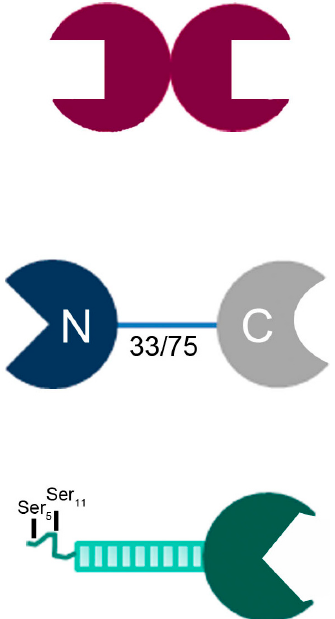
Figure 1. Illustration of the structural design of the three classes of vertebrate galectins, i.e., non-covalently associated homodimer (proto-type), covalently linked heterodimer (with natural variability of linker length by alternative splicing, here given in number of amino acids, for human Gal-8; tandem-repeat-type) and trimodular combination of a C-terminal CRD with nine non-triple helical collagenous repeats and an N-terminal peptide with two sites for serine phosphorylation (chimera-type).